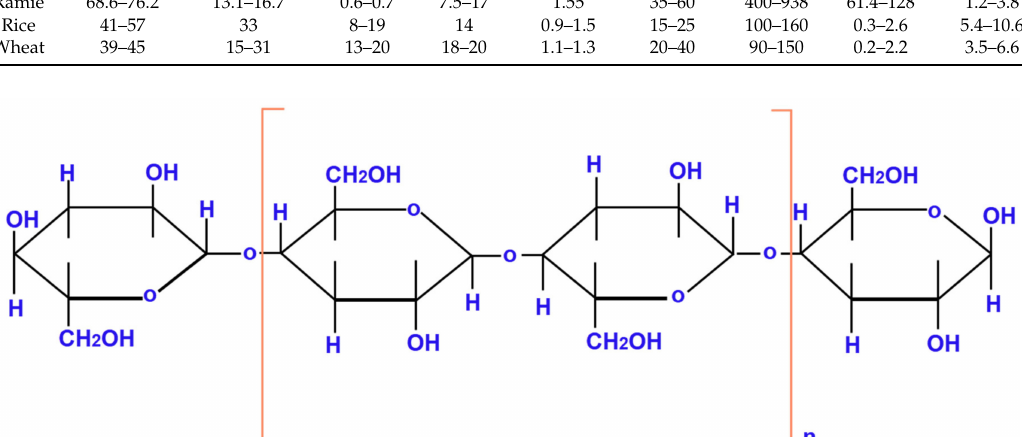
Figure 4. The chemical structure of cellulose. Reprinted with permission from [52]; Copyright 2011 Elsevier.